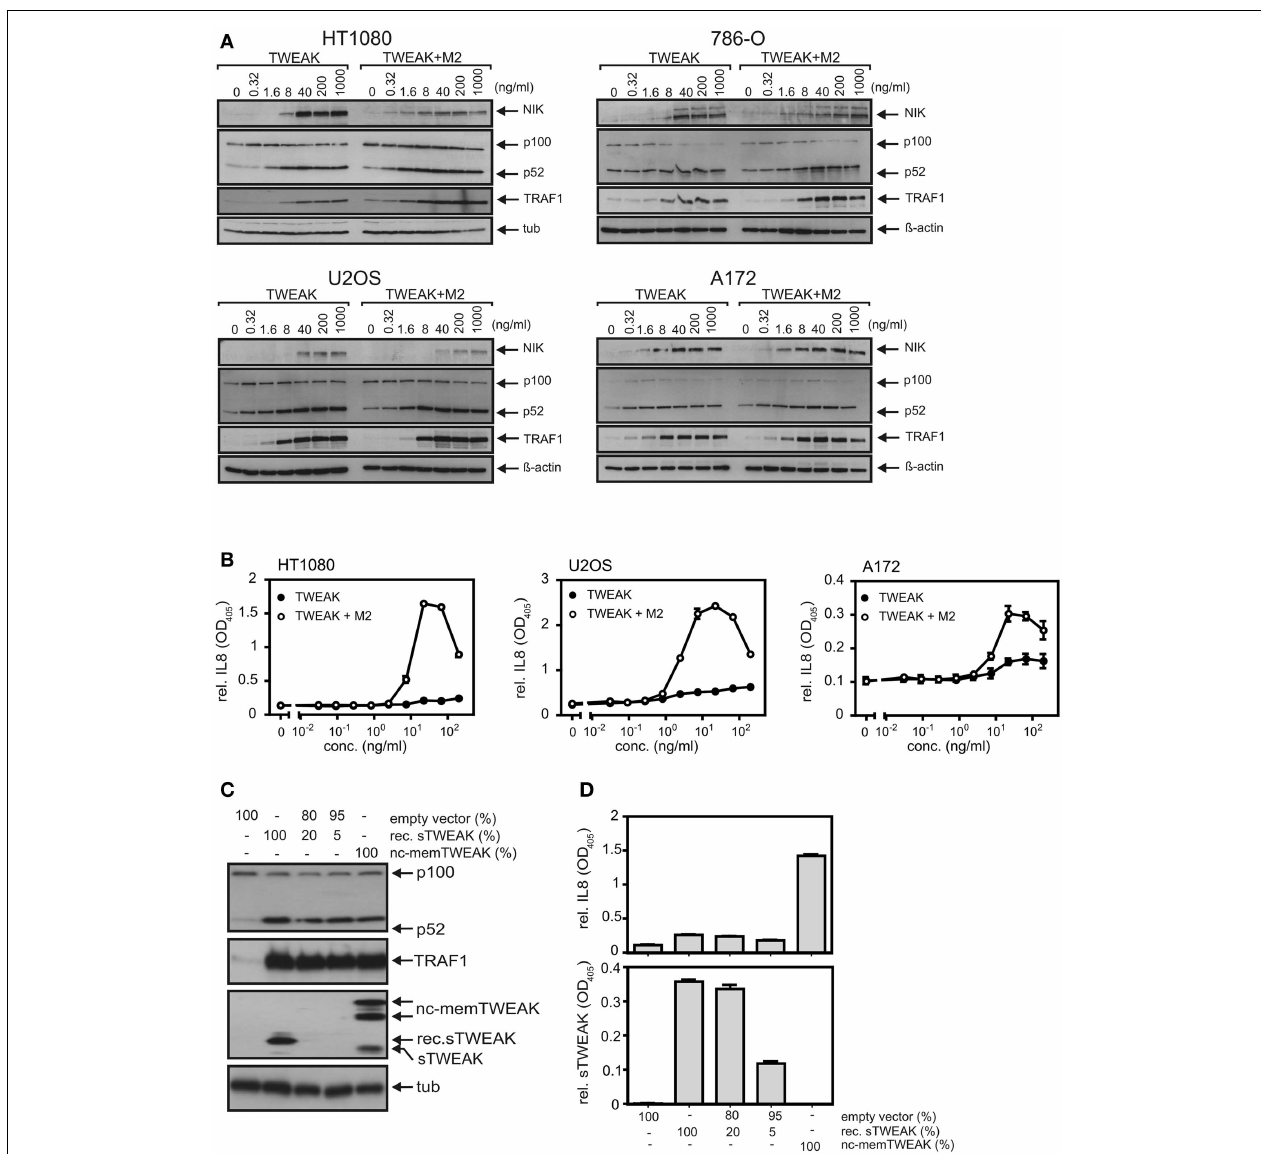
production observed at high concentrations of anti-Flag oligomerized Flag-TWEAK presumably reflects suboptimal complex formation by M2 and Flag-TWEAK. (C,D) HT1080 cells were transiently transfected with the indicated mixtures of expression plasmids encoding soluble Flag-TWEAK (rec. sTWEAK) or a non-cleavable mutant of membraneTWEAK (nc-memTWEAK) and empty vector. Next day, cells were harvested and seeded in 6-well and 96-well plates. After an additional day, total lysates derived of transfected cells (6-well) were analyzed by western blotting for expression of the indicated proteins (C) and supernatants (triplicates) were analyzed with respect to their IL8 andTWEAK content by ELISA (D)